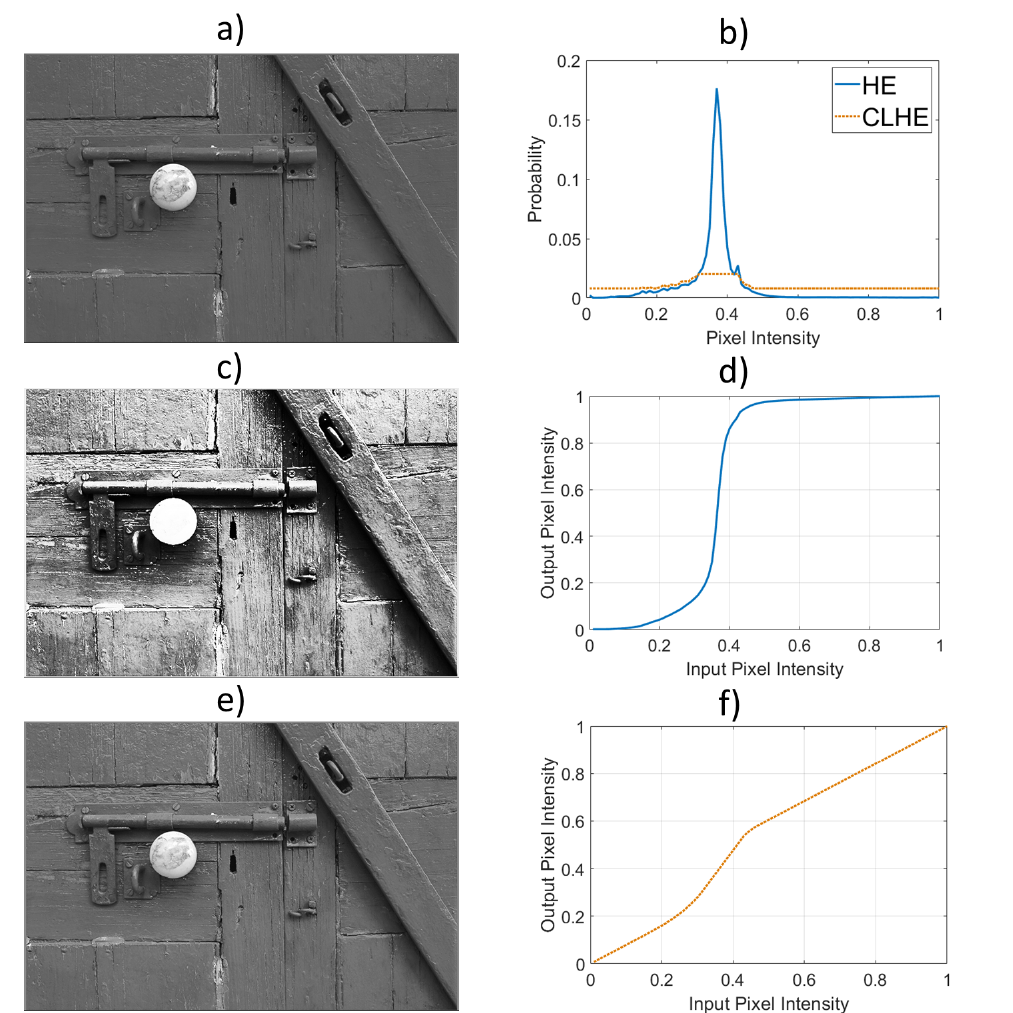
Figure 1. An illustration of HE and CLHE . ( a ) Original image. ( b ) Brightness histogram of ( a ) (solid blue), and CLHE proxy histogram (dotted red). ( c ) Image enhanced with HE . ( d ) HE tone curve. ( e ) Image enhanced with CLHE . ( f ) CLHE tone